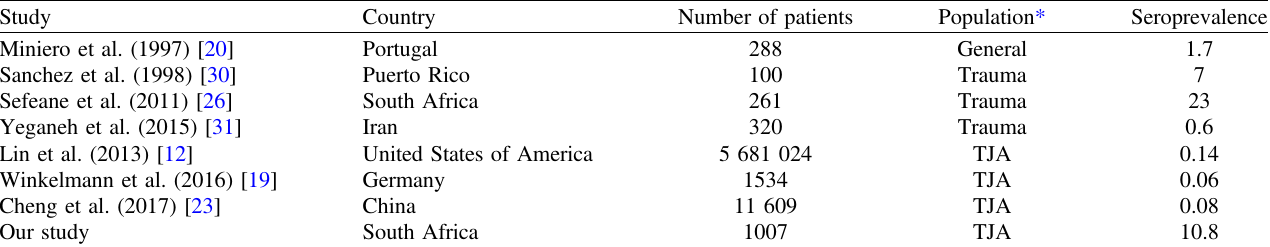
Table 4. Seroprevalence of HIV in patients for orthopaedic surgery.